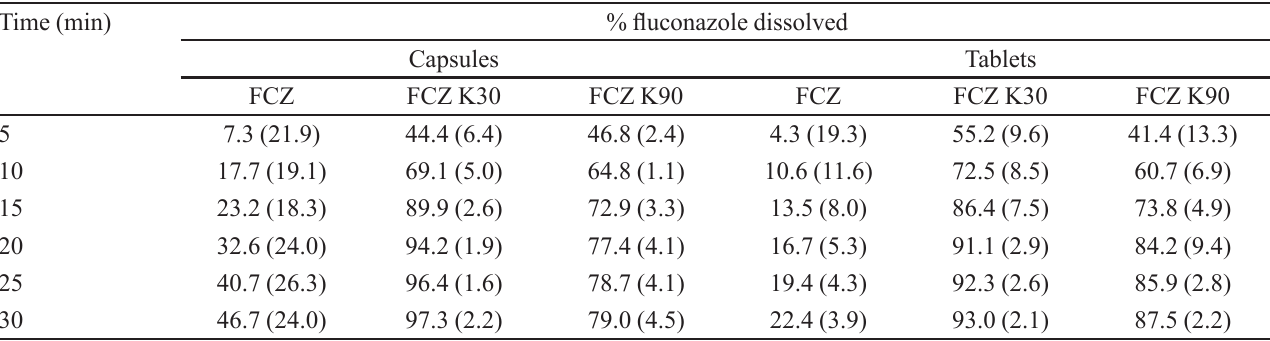
TABLE V – Percentages of drug dissolved for capsules and tablets produced with fluconazole (FCZ) and granules (FCZ K30